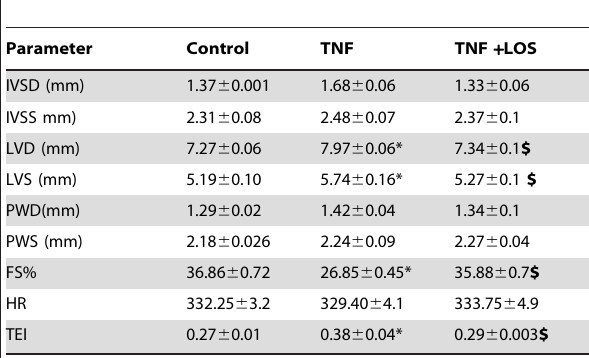
Table 3. Echocardiographic data from experimental